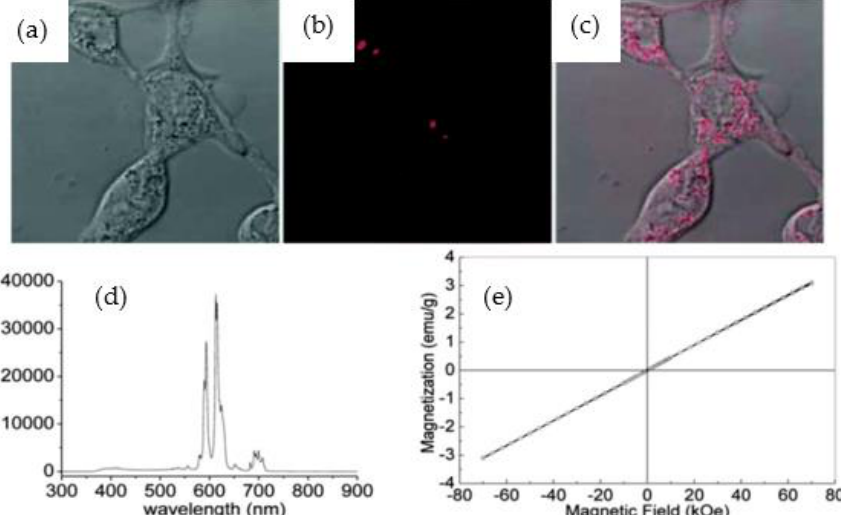
Figure 7. ( a ) Fluorescence image of Dox loading BNNTs@NaGdF 4 : Eu; ( b ) LNCaP prostate cancer cells fluorescence image; ( c ) Overlapped fluorescence image in red colour emissions of composites uptake by cancer cells; ( d ) Photoluminescence emission spectrum loading BNNTs@NaGdF 4 :Eu; ( e ) Function of magnetisation at room temperature for BNNTs@NaGdF 4 :Eu composites. Reproduced with permission from Ref. [61]. Copyrights 2014, Royal Society of Chemistry.